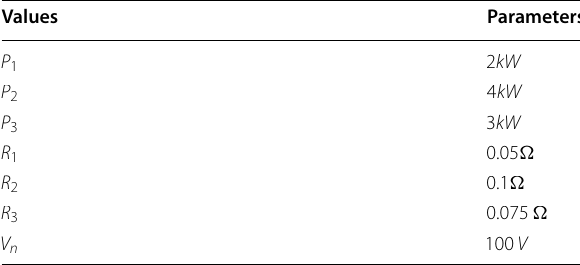
Table 1 System data and cable impedances Values